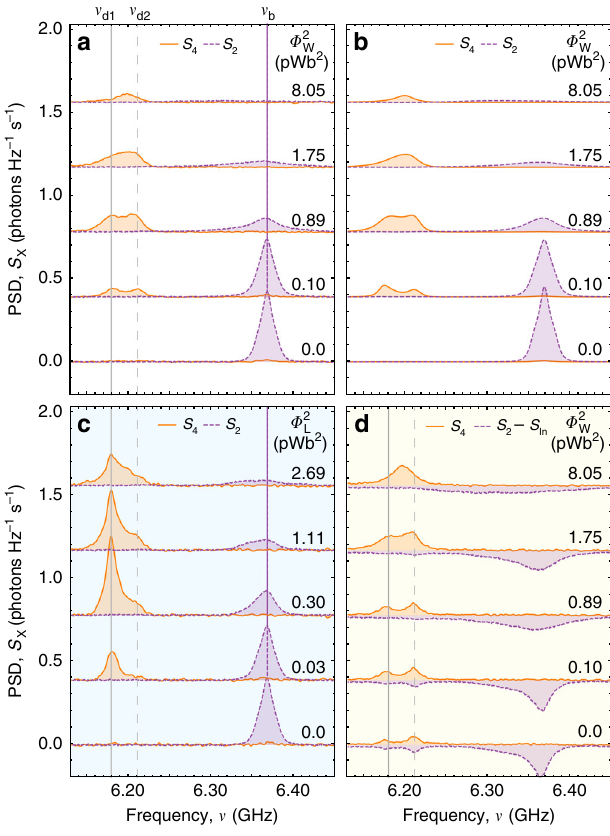
Fig. 3 Measured power spectral densities (PSD). PSD of radiation extracted from the resonator S 4 ( ω ) (solid orange lines) and re-emitted into the transmission line S 2 ( ω ) (dashed purple lines) for coherent excitation as a function of a white noise power Φ 2 and c Lorentzian noise power Φ 2 . W L b Master equation calculations of S 4 ( ω ) and S 2 ( ω ) for coherent excitation as a function of Φ 2 . d Measured PSD for incoherent excitation as a function W of Φ 2 . Dashed purple lines represent a difference between measured S 2 ( ω ) W and PSD of incoherent microwave radiation S in . PSD for different noise powers are displaced by 0.2 photons s − 1 Hz − 1